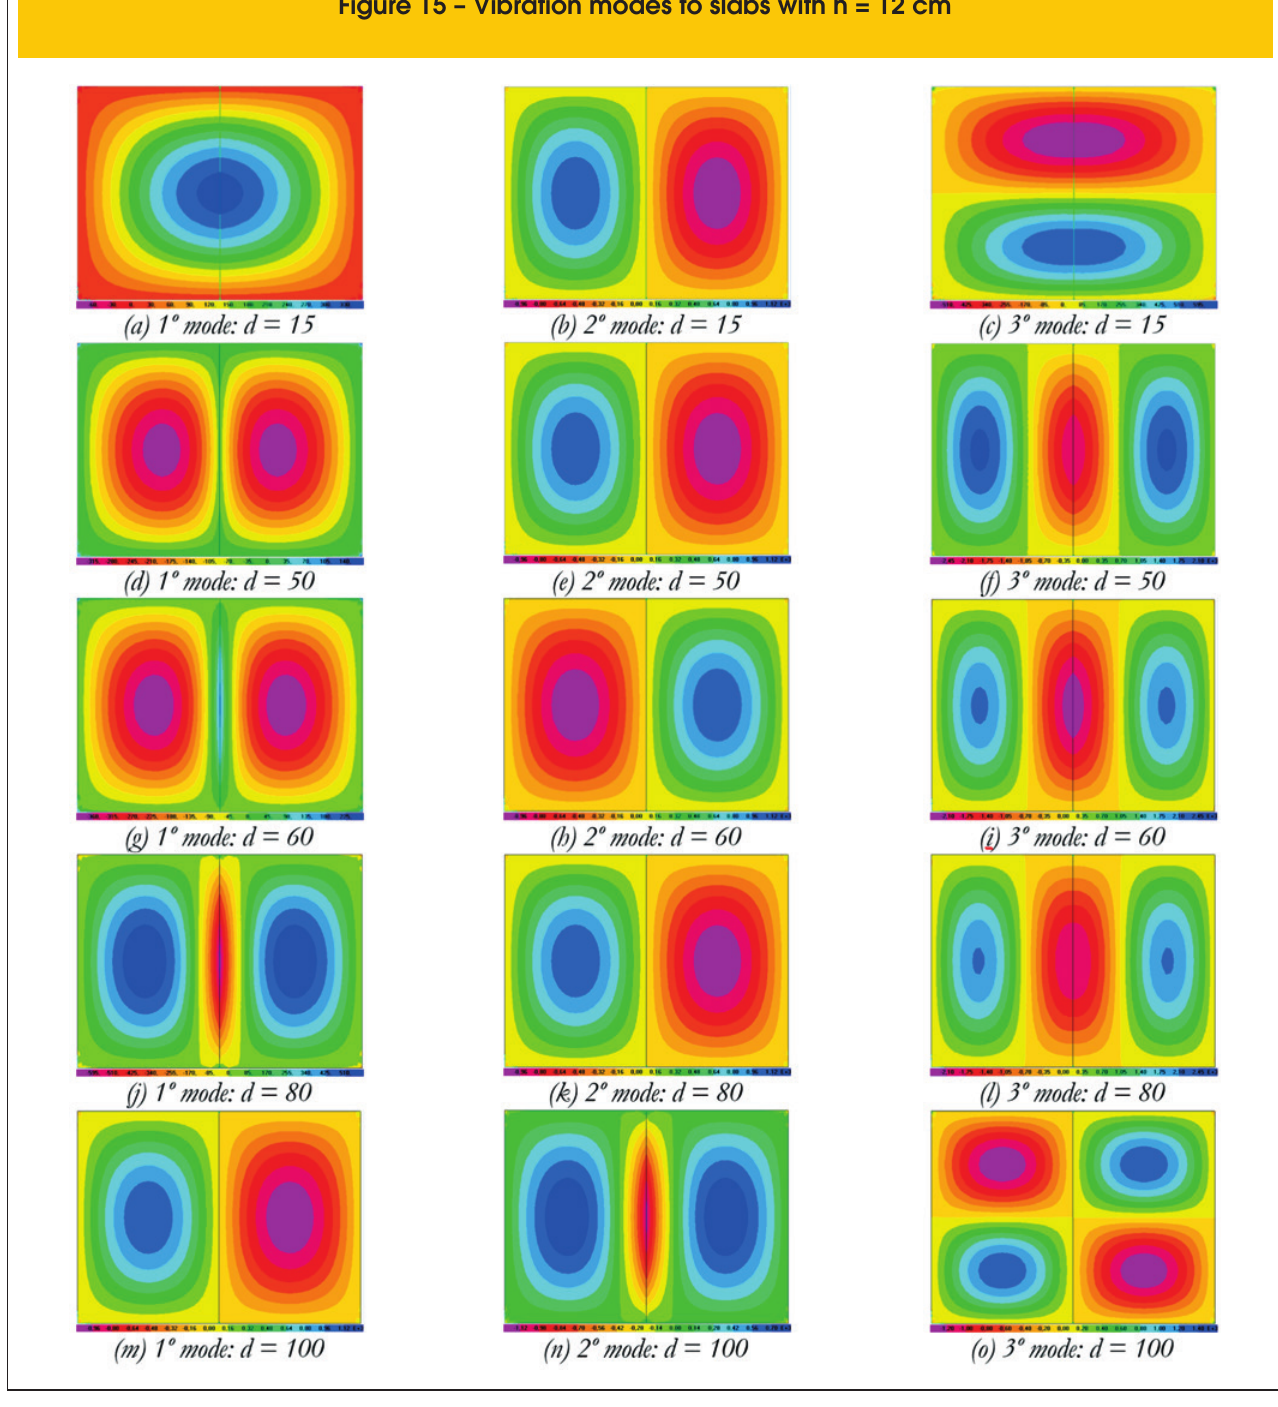
Figure 15 – Vibration modes to slabs with h = 12